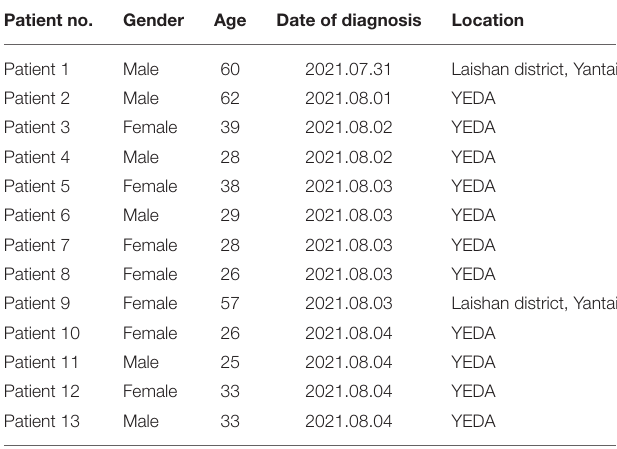
TABLE 1 | Details of patients involved in this